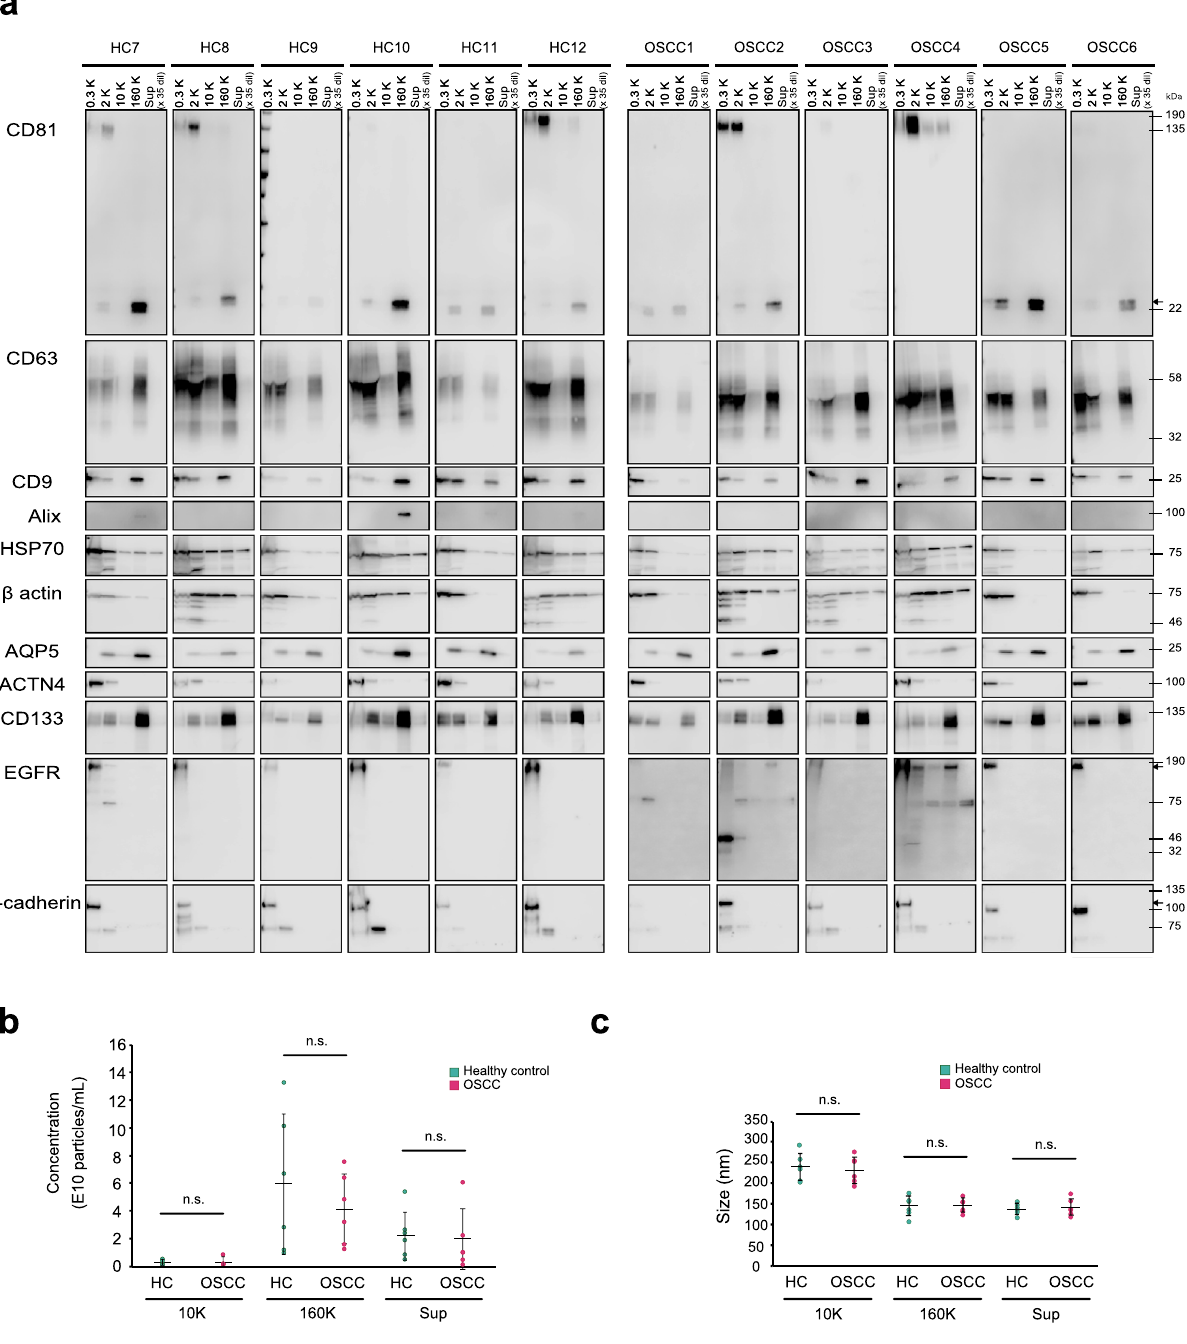
Figure 3. Comparative analyses of pentapartite oral fluid (OF) fractions between healthy volunteers and patients with OSCC. ( a ) Western blot analyses of pentapartite fractions from six healthy subjects (HC7 to HC12) and six patients with OSCC (OSCC1 to OSCC6). Membranes were probed with antibodies against CD81, CD63, CD9, Alix, Hsp70, β-actin, AQP5, ACTN4, CD133, EGFR, and E-cadherin. Numbers on the right indicate molecular weight (MW) × 10 –3 of for MW markers. Black arrows show the reported sizes of the proteins. Nanoparticle tracking analyses (NTA) of particles contained in the 10K, 160K, and Sup fractions derived from healthy controls and patients with OSCC. Particle concentrations ( b ), and mode diameters ( c ), are indicated by green and red dots, respectively. The mean value of each group is represented as a solid horizontal line. The two- tailed unpaired t- test was used to evaluate statistical significance. Statistical significance was defined as p < 0.05. n.s. not